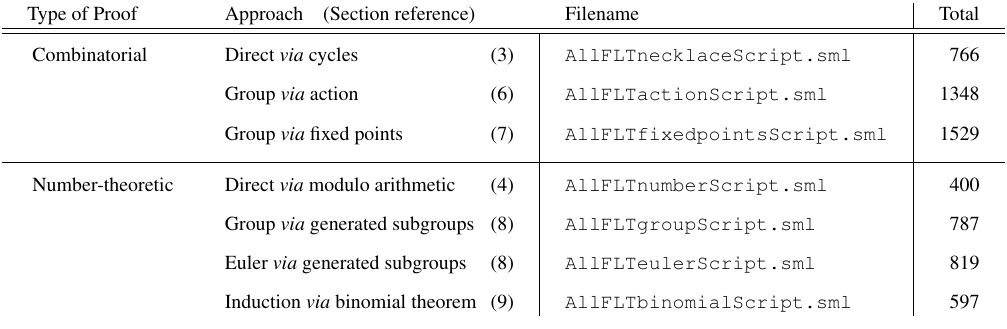
Table I. Line counts for theories developing each approach. Filename is that of the linearised script in bitbucket.org repository.